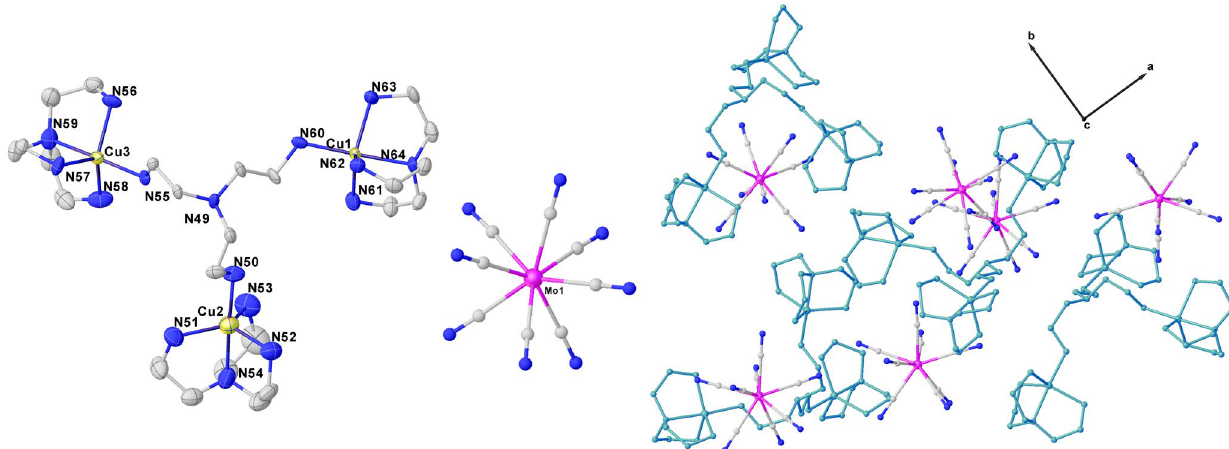
Figure 1. [{Cu(tren)} 3 ( µ -tren)] 6+ ( left ), [Mo(CN) 8 ] 4 − ( middle ) selected fragments with partial atoms labelling and asymmet- ric unit of 1 (without solvent entities) viewed along c with [{Cu(tren)} 3 ( µ -tren)] 6+ units in green ( right ). Color codes: N, blue; C, grey; Cu, yellow; Mo, pink.